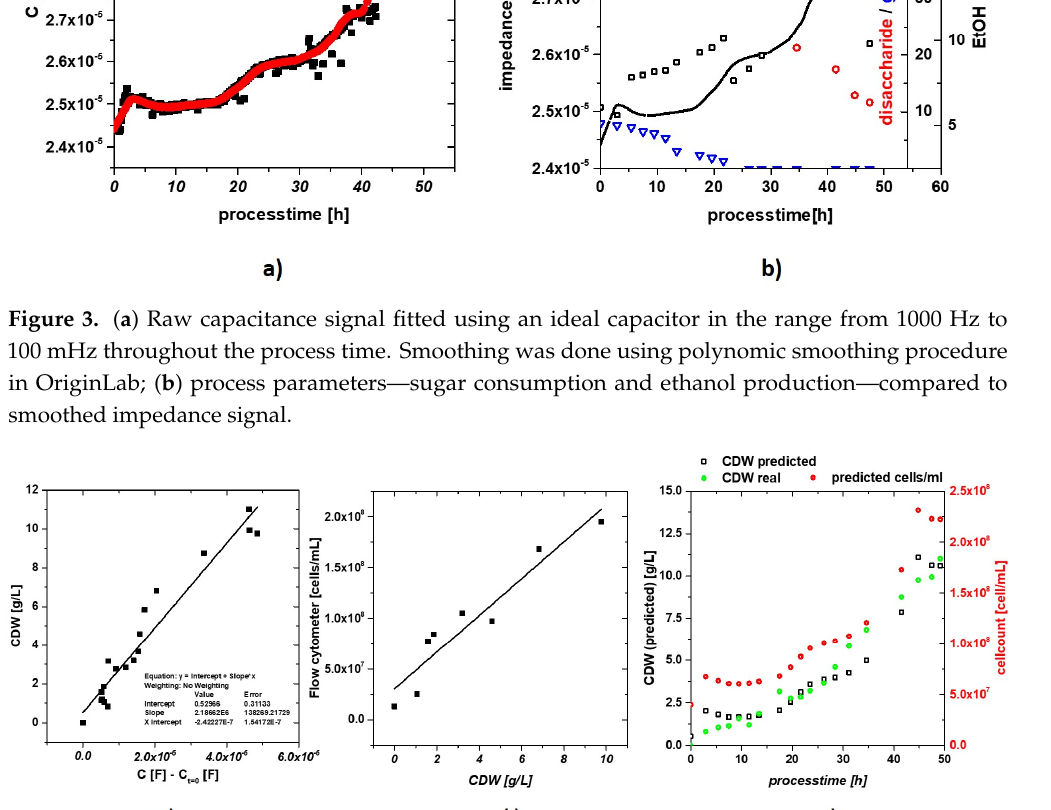
Figure 3. a) Raw capacitance signal fitted using an ideal capacitor in the range from 1000 Hz to 100